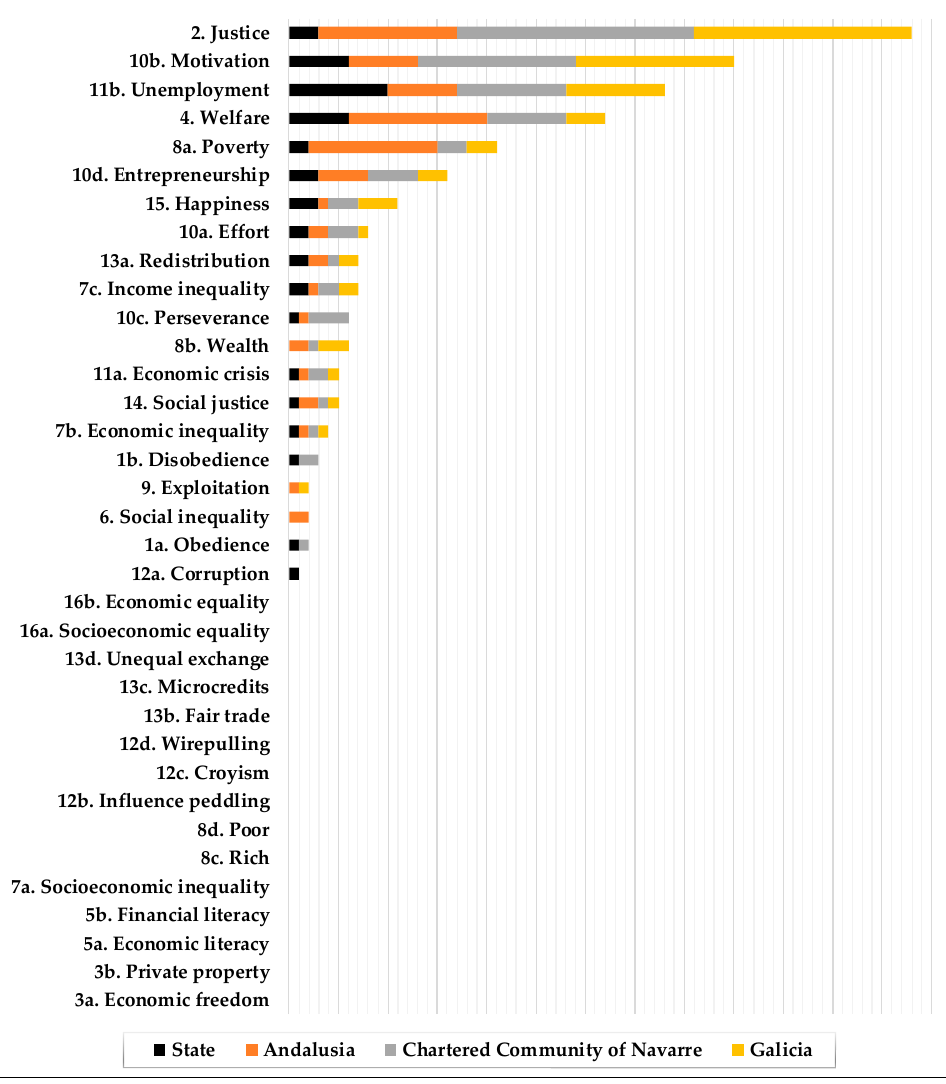
Figure 1. Number of keywords per administrative body.